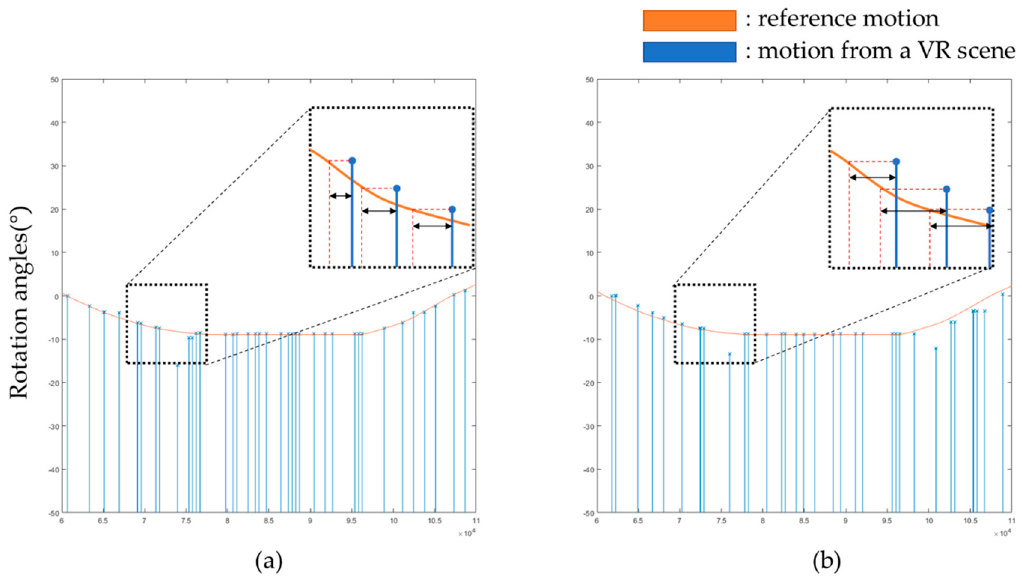
Figure 12. Profiled motion data measured from the physical motion and a virtual reality (VR) output image: ( a ) workload level 0 and ( b ) workload level 3.